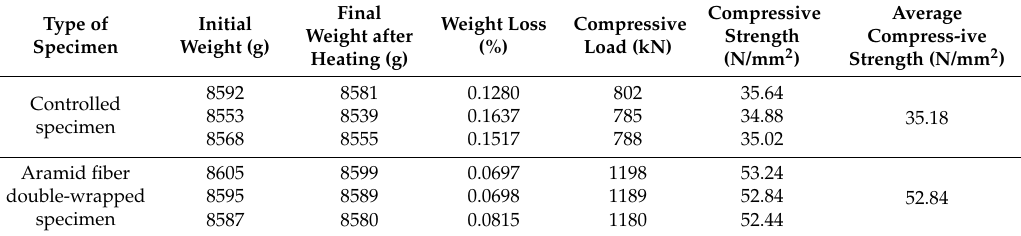
Figure 7. Compressive strength at 200 °C—1 h.